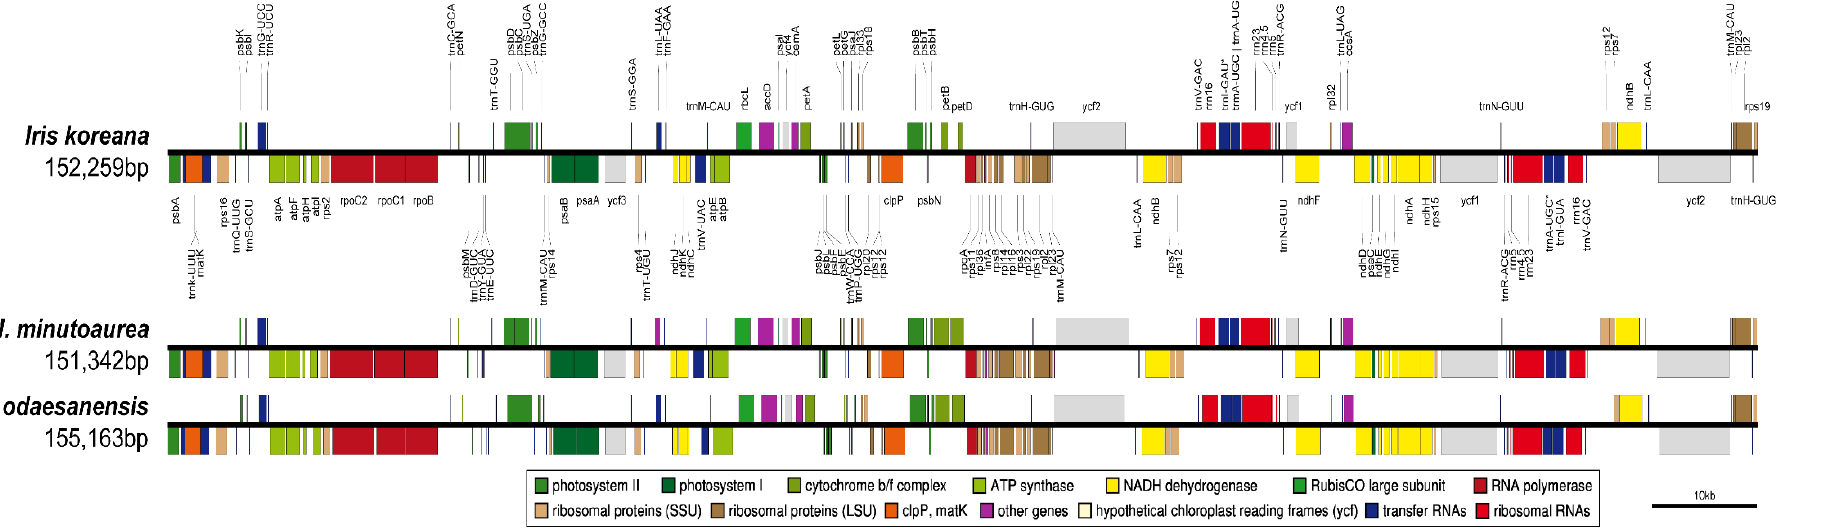
Figure 3. Linear gene map of the chloroplast genomes of the three analyzed Iris species. Genes are transcribed from the left to right. Genes indicated above the first black horizontal line from the top are positioned in the forward direction (left to right). Genes right below the first black horizontal line are positioned in the reverse direction (left to right).